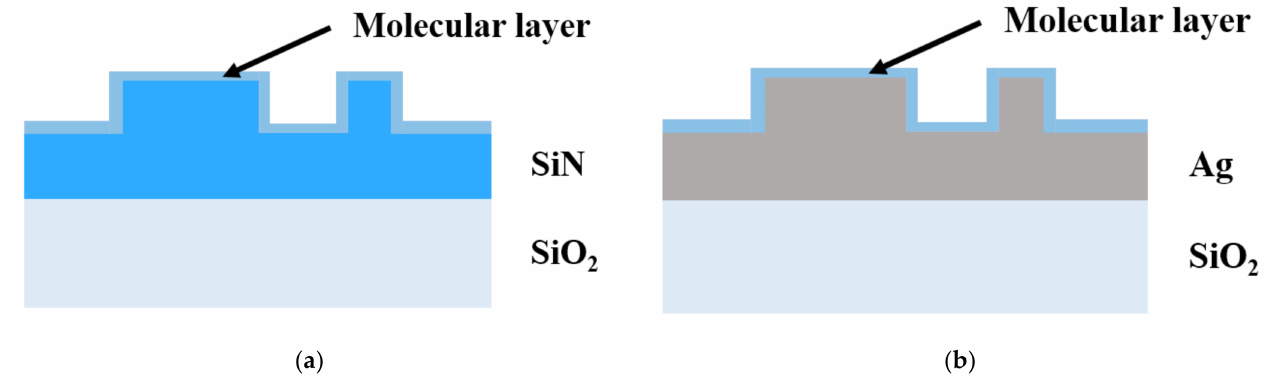
Figure 8. The demonstration of surface sensitivity calculation. Reflectivity of the molecular layer is changed in calculation. ( a ) The grating and waveguide layers are made of SiN. ( b ) The grating and waveguide layers are made of Ag.